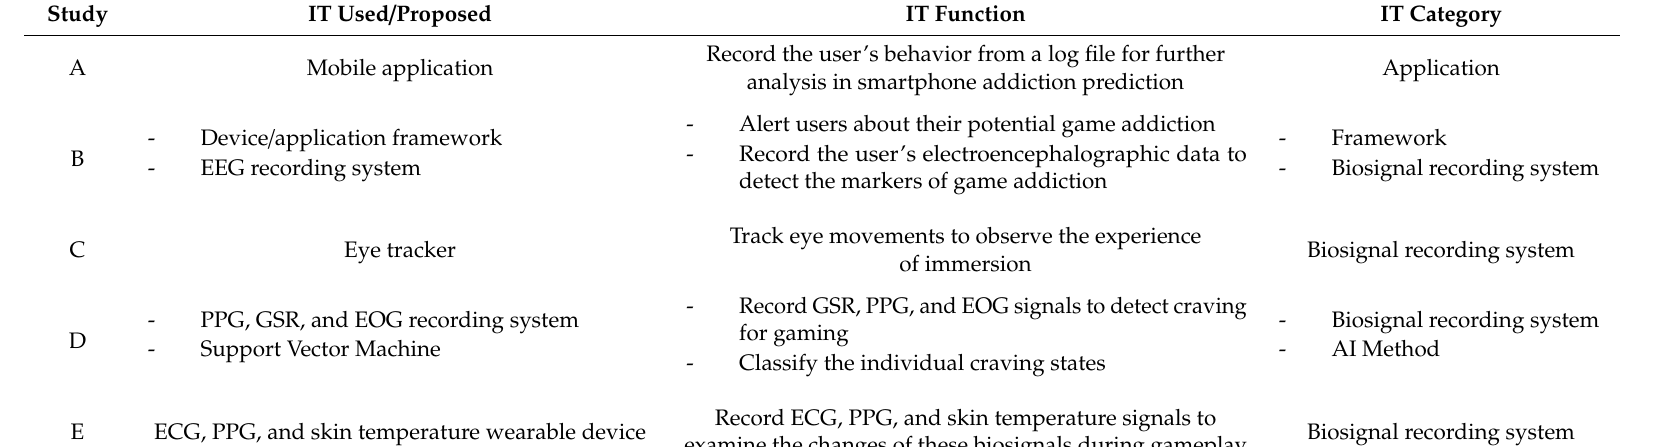
Table 2. The IT used / proposed and its